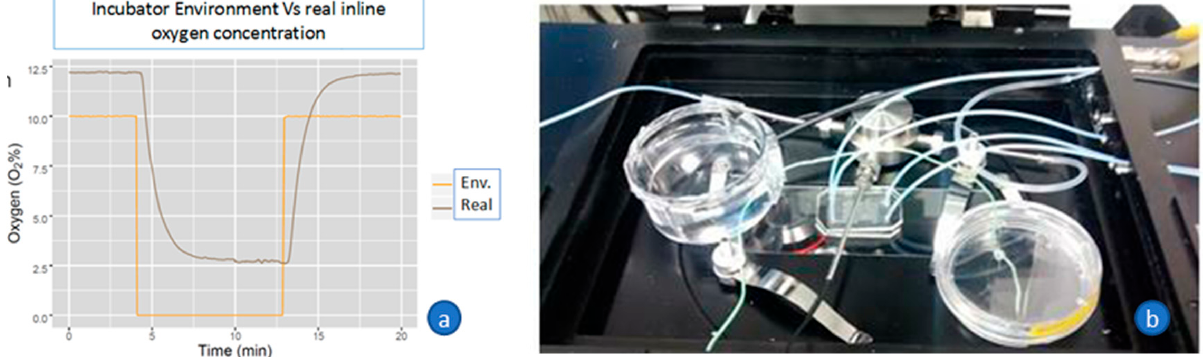
Figure A3. Schematic of cell-seeding areas in OoC device. ( A ) Top view of a µBBB device with an augmented image of the grid indicating an example of a top channel (vertical), bottom channel (horizontal), and a cross-section (indicated with a square in the centre). ( B ) Schematic of the transversal structure of each cross-section in the device. Pericytes are seeded in the top channel in contact with the polycarbonate membrane. Endothelial cells are seeded in the top channel, both in contact with the membrane and in contact with the bottom of the device. Each channel is supplied with its own cell-specific culture medium. The positions analysed for imaging purposes are indicated as bottom-position and membrane-position. Table A1. Direct polymer bonding results. (*) low optical quality; (**) Good results only on one side of the membrane, unable to obtain a proper polymer-PC membrane-polymer sandwich; (-) not tested. 1st Mate- rial